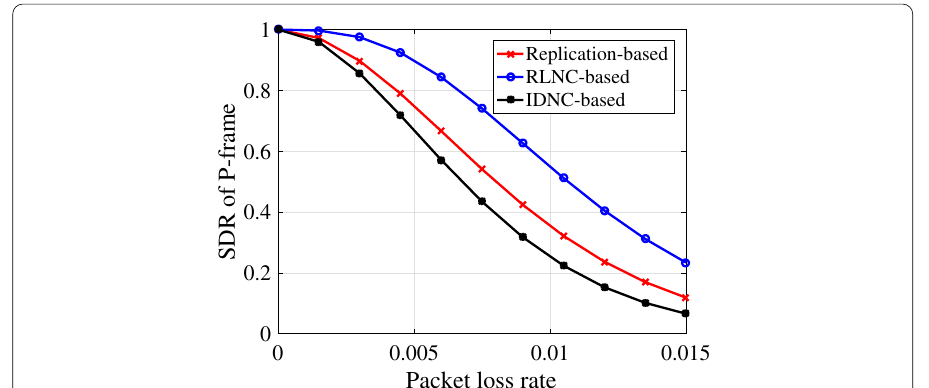
Fig. 6 Comparison of the SDR of P-frame in different schemes